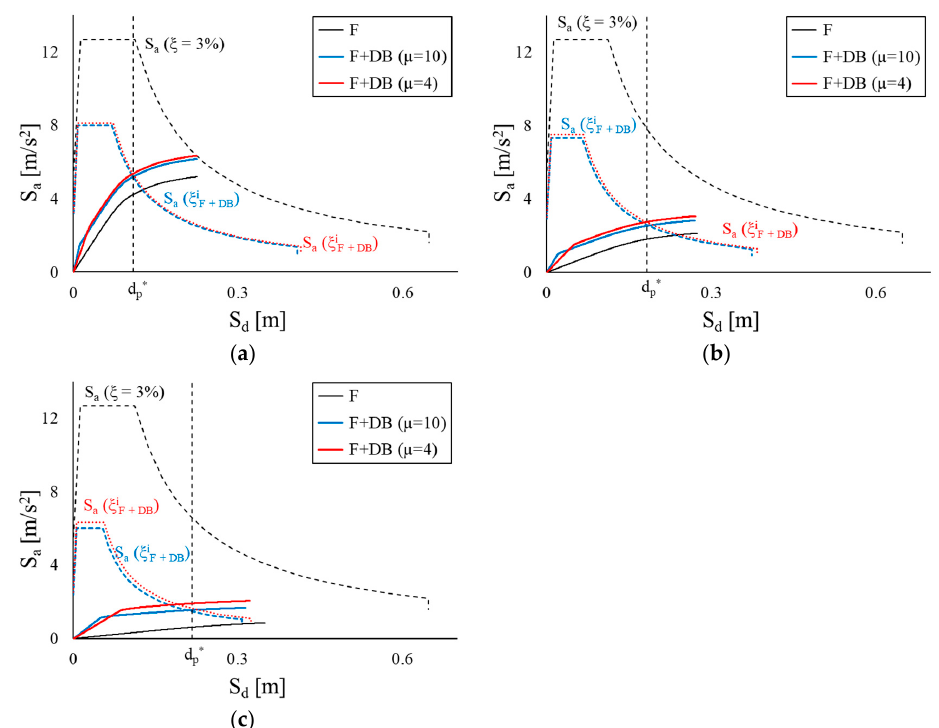
Appl. Sci. 2023 , 13 , x FOR PEER REVIEW Figure 11 . Results of NSLAs in X -direction of ( a ) two-story, ( b ) four-story, and ( c ) eight-story Figure 11. Results of NSLAs in X-direction of ( a ) two-story, ( b ) four-story, and ( c ) eight-story structures. structures.